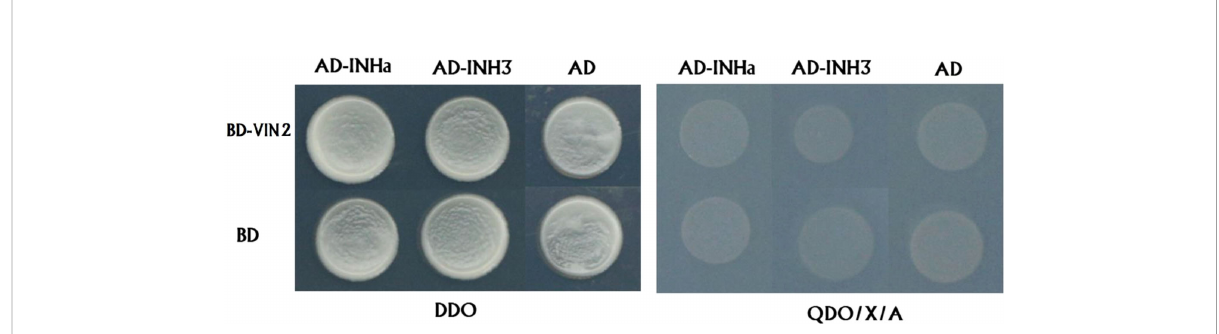
FIGURE 5 Investigation of interaction between PpVIN2 and either PpINHa or PpINH3 and using Y2H. PpVIN2 was used as bait, while PpINHa and PpINH3 were used as prey. Empty-BD and empty-AD were co-transformed as negative controls. DDO and QDO/X/A represent SD/-Leu/-Trp, SD/- Leu/-Trp/-His/-Ade/X- a -gal/AbA, respectively.